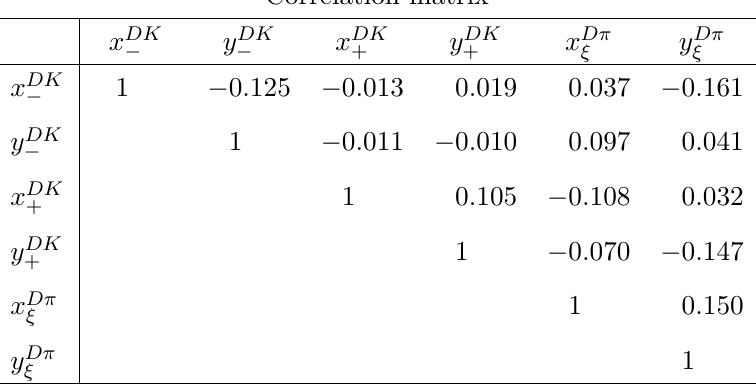
, y DK , x Dπ , and y Dπ . ± ± ξ ξ